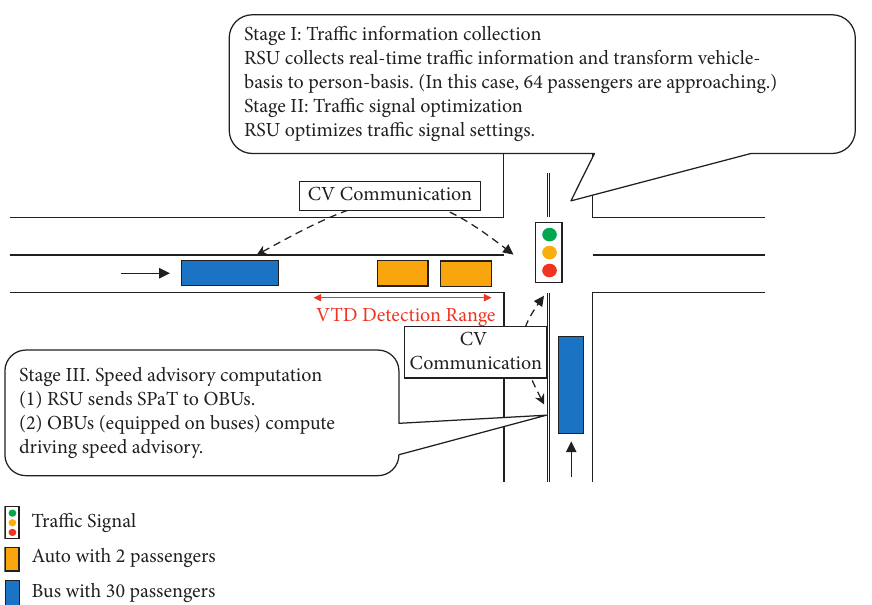
Figure 1: The process of